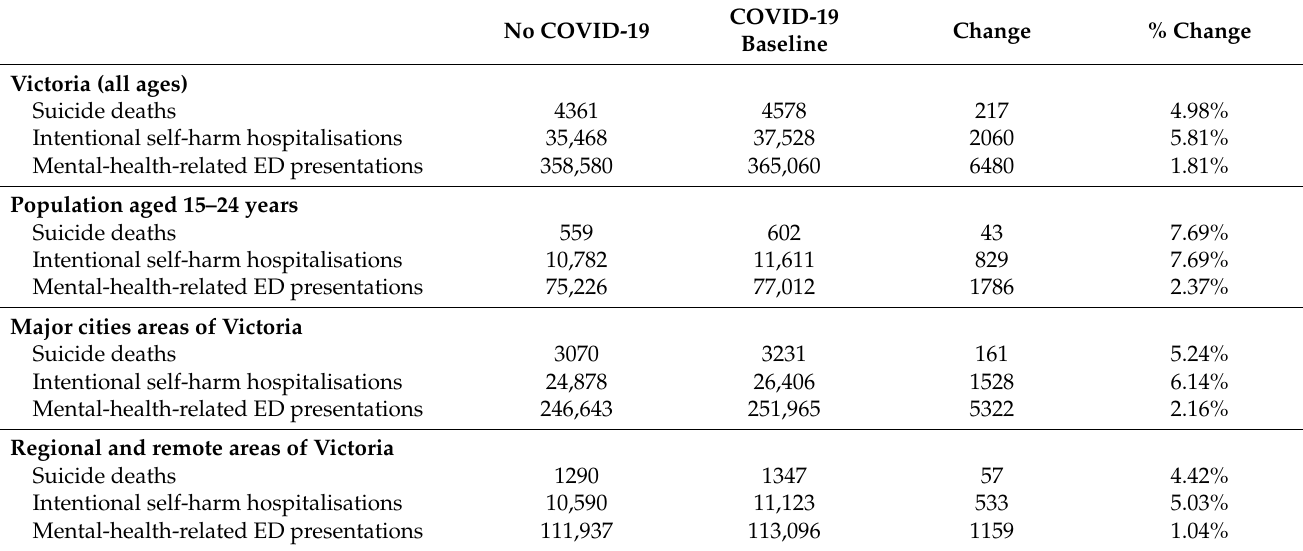
Table 2. Projected cumulative adverse mental health events between March 2020 and March 2026, comparing a no-pandemic scenario against baseline with COVID-19. Event numbers are rounded to the nearest